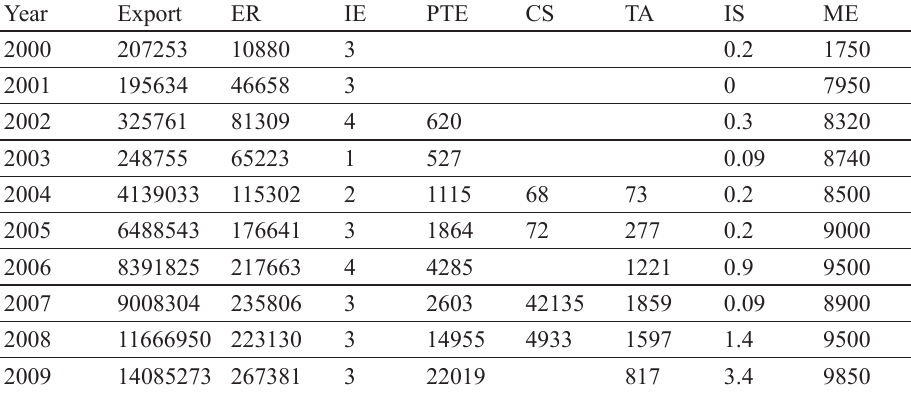
Table 1. EPPs and export data covering the period from January 2000 to December 2009